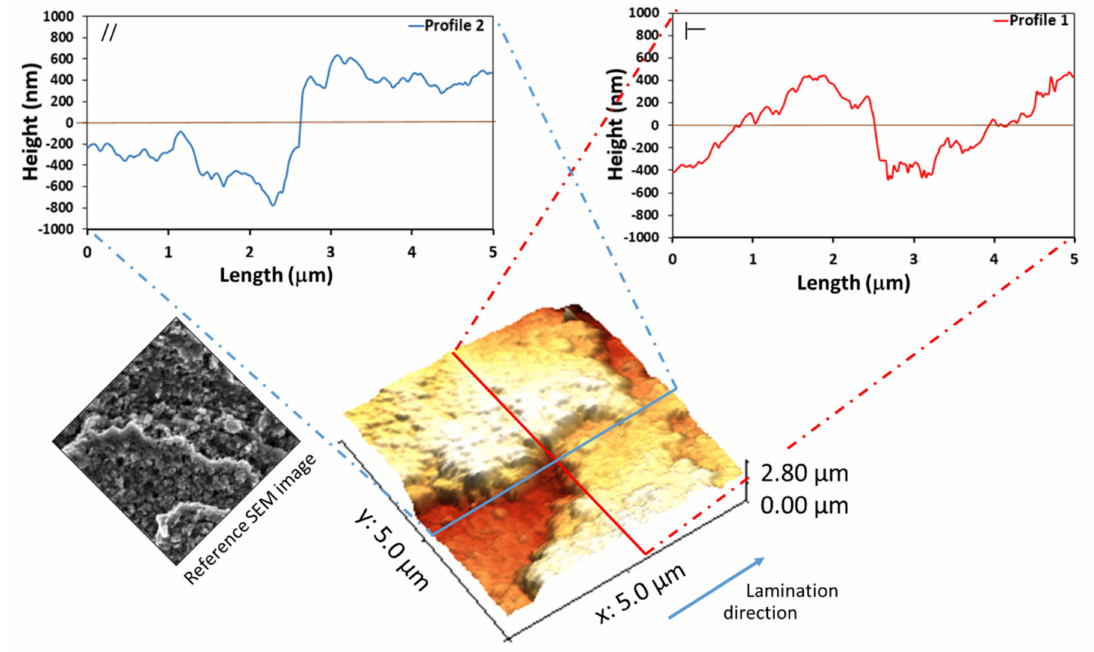
Figure 4. Three-dimensional AFM map and the two direction profiles of Al-FS.